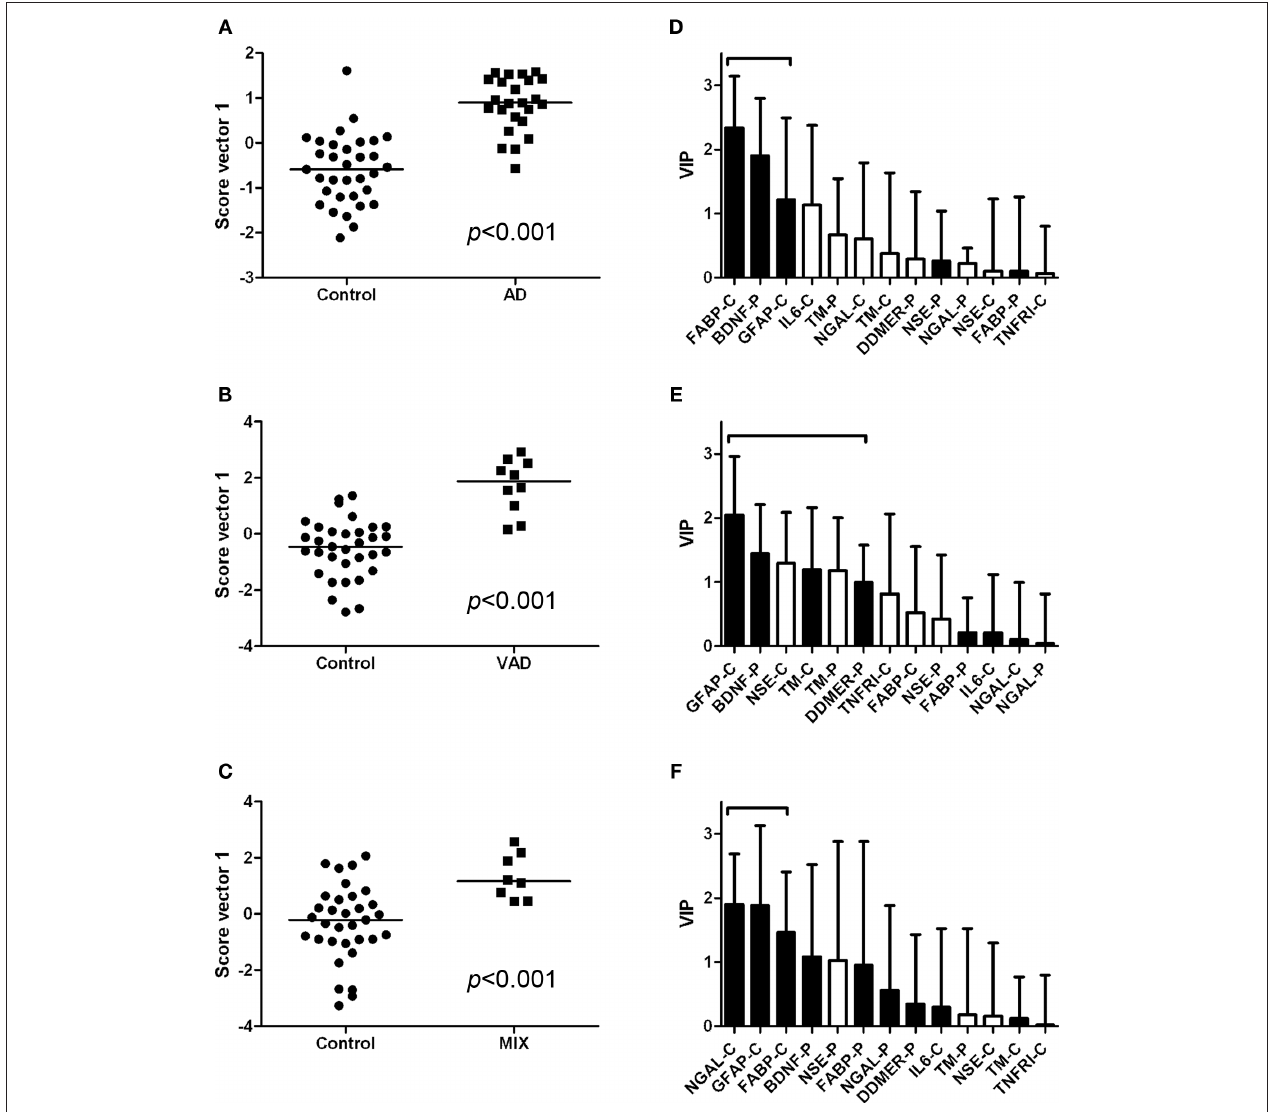
FIguRE 5 | Scatter plots and VIP tables for the groups compared. (A–C) Show scatter plots from OPLS-DA, while (D–F) display the corresponding variable importance in projection (VIP) plots. A black bar indicates an elevated level of the analyte in the disease group, whereas a white bar indicates an elevated level in the control group. The analytes that contribute significantly to the separation of the diagnostic groups are marked with a